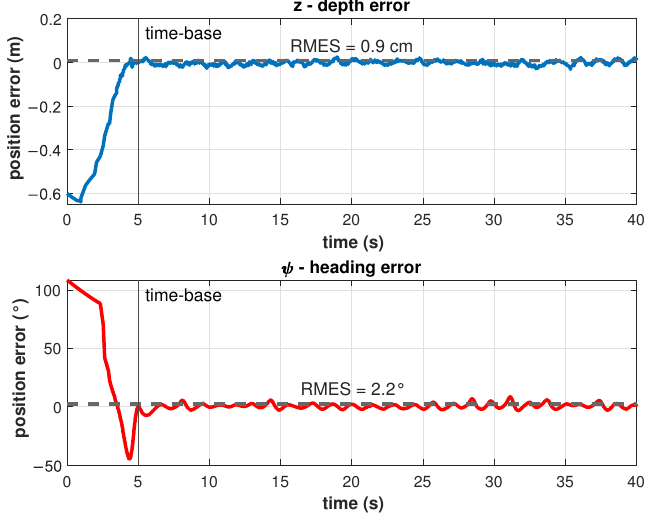
Figure 12. Tracking error for depth and heading